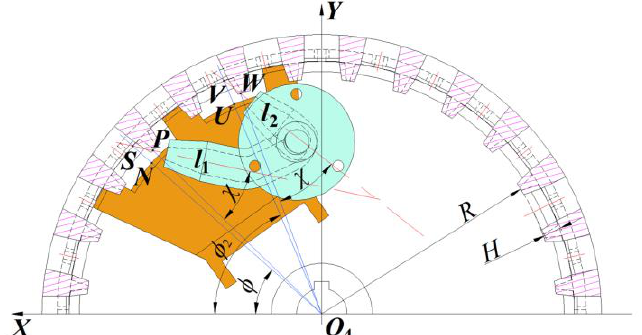
Figure 9. Analysis of the inclination angle of the central axis of the outlet section of the seed-disturbing air nozzle. Note: l 1 , first outlet section axis of the air nozzle; l 2 , the second outlet section axis of the air nozzle; S , intersection of the axis l 1 and the lower bottom surface of the filling hole; V , intersection of the axis l 2 and the lower bottom surface of the filling hole; N , midpoint of the largest arc of the baffle between the first and second segment scrapers; U , midpoint of the largest arc of the baffle between the second and third segment scrapers; P , intersection of the axis l 1 with the inner circle of the seeding plate; W , intersection of the axis l 2 with the inner circle of the seeding plate; and φ 2 , angle between the symmetrical centerline of the first and second segment scrapers and the horizontal axis of the seeding plate, (°).